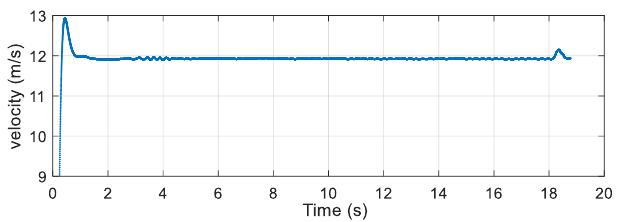
Figure 19. Falling velocity of the airdrop experiment.